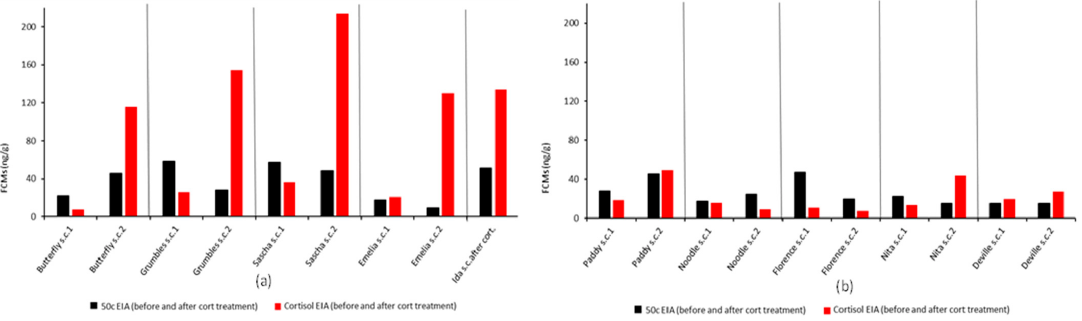
Figure 4. FCM (faecal cortisol metabolite) values of the 2-day scat (faeces) collection (s.c.1 and s.c.2) of 10 koalas (names shown on the x axis) measured by 50c (black bars) and cortisol EIAs (enzyme immunoassays) (red bars). Second samples (s.c.2) shown in ( a ) were collected during the systemic administration of GC and show artificial increase in FCM values measured by the cortisol EIA. Second samples in ( b ) were collected after the systemic GC administration was terminated and were also measured by the cortisol EIA, but show no artificial increase in values. No artificial increases are seen with the 50c EIA following GC administration.